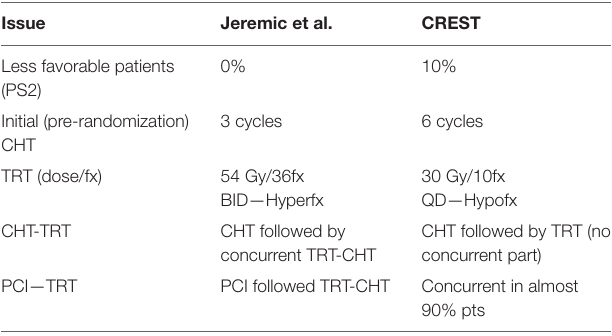
TABLe 1 | Patient and treatment